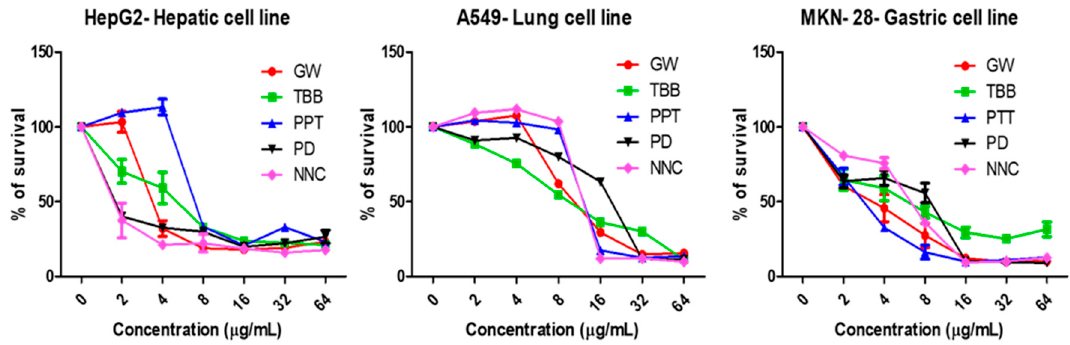
Figure 6. Cytotoxicity: Mammalian cells (HepG2, A549, and MKN-28) were treated with 2-fold serial